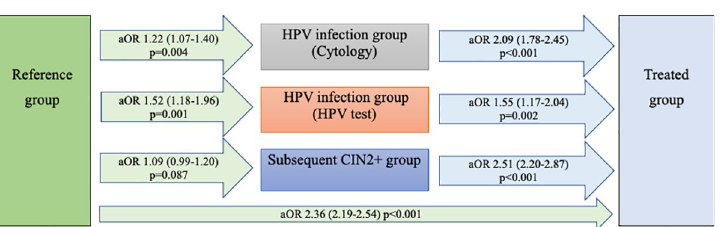
Fig 3. Risk of pPROM—adjusted logistic regression. Women with HPV infection had an increased risk of pPROM; treatment increased the risk further. aORs are given, with 95% confidence intervals in parentheses. Analyses adjusted for year of delivery, maternal age, parity, BMI, marital status, country of birth, infant’s sex, smoking, income, education level, and assisted reproduction. aOR, adjusted odds ratio; CIN, cervical intraepithelial neoplasia; HPV, human papillomavirus; pPROM, preterm prelabor rupture of membranes.